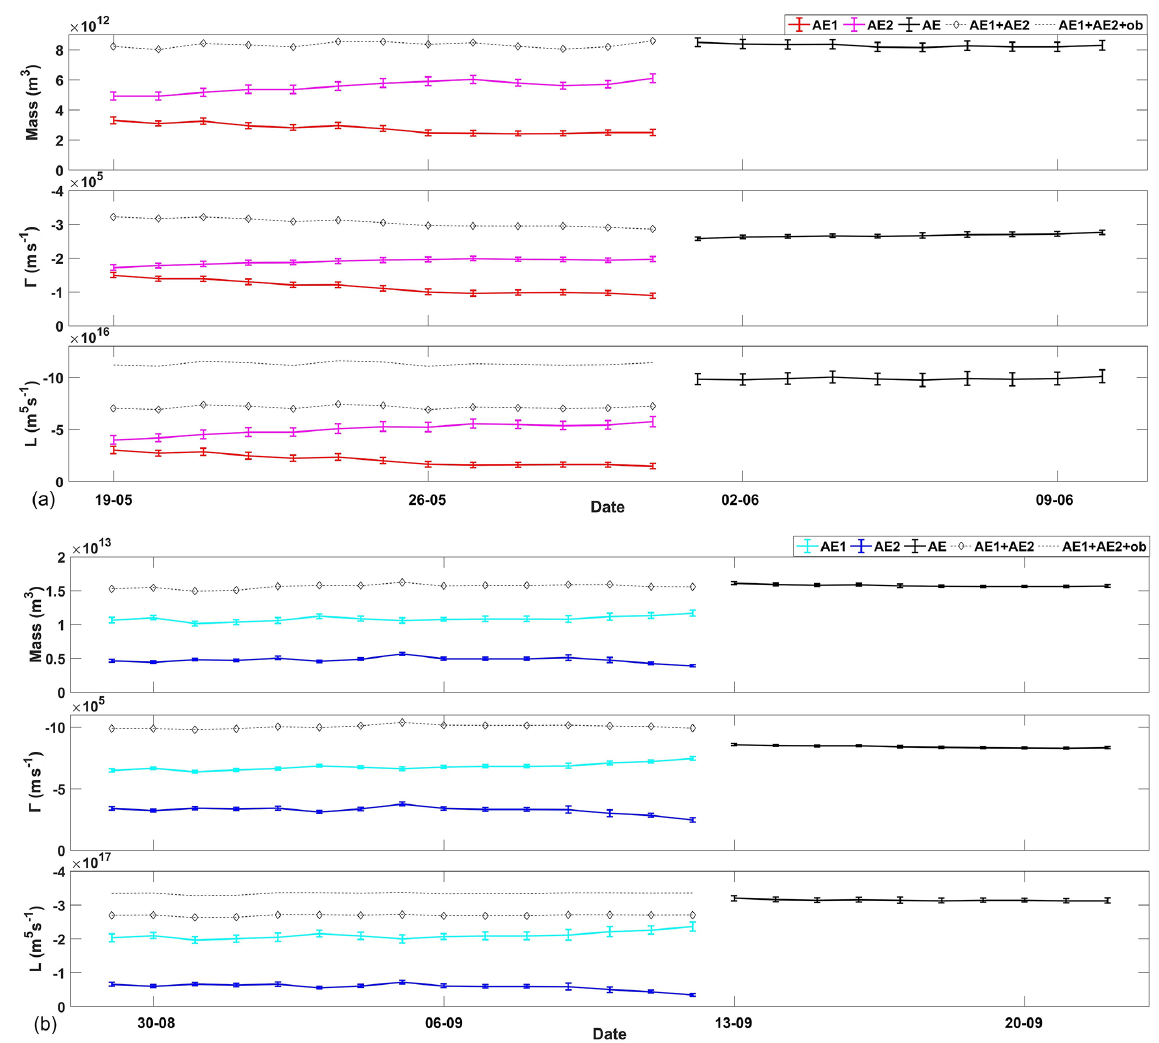
Figure 8. The eddy properties (mass, circulation, and angular momentum) with a thicker H 1 = 300m in the merging event of (a) surface mesoscale eddies and (b) subsurface mesoscale